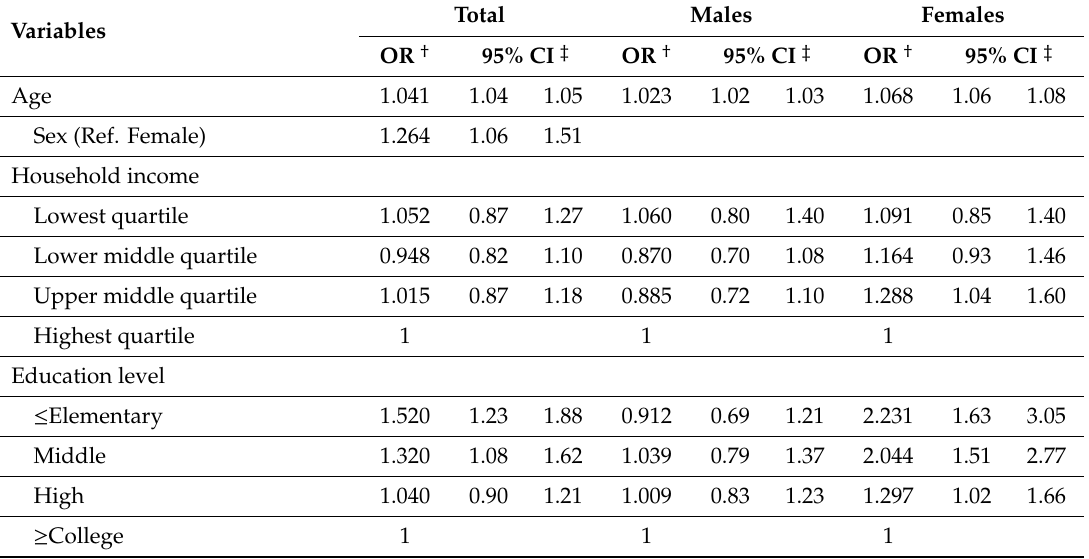
Table 3. The adjusted association of MetS with periodontitis in total and by